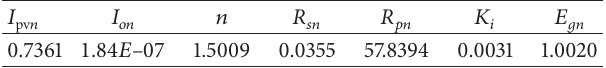
Table 2: Parameters of the ISDM obtained by the CS algorithm.